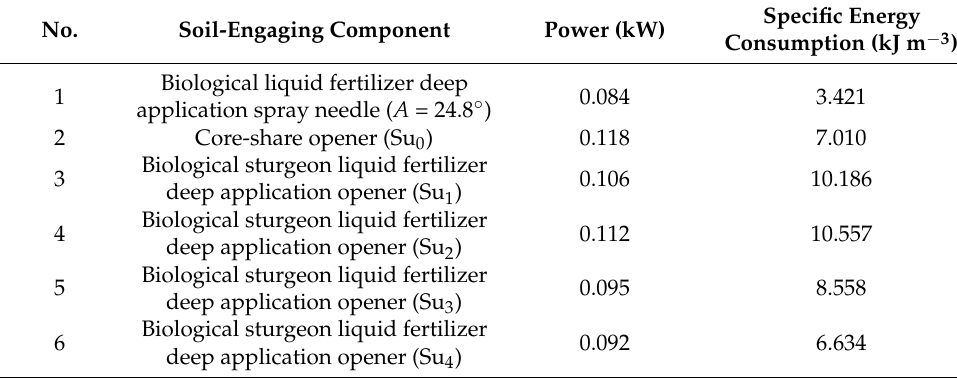
Table 5. Comparison between DEM virtual simulation test results and indoor soil bin test results.